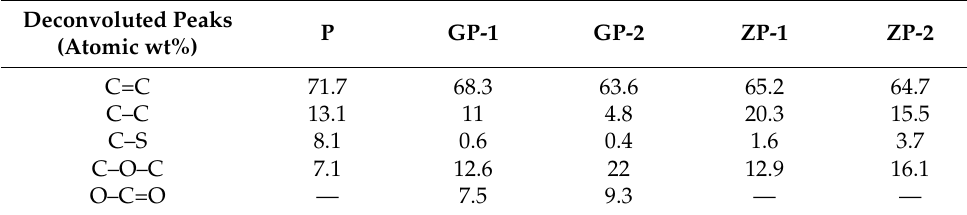
Table 4. Quantification of deconvoluted XPS C1s spectra of fabricated membranes.